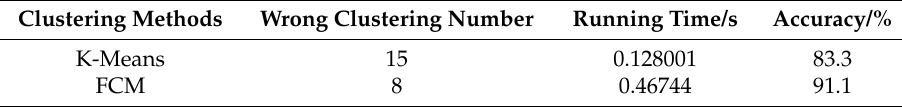
Table 7. The experimental comparison results of K-Means algorithm and FCM